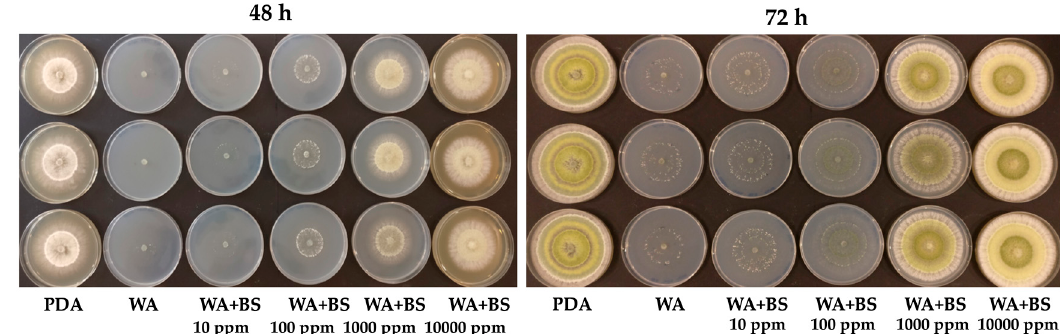
Figure 4. T. harzianum TH01 growing in starvation conditions in the presence or absence of BS2 ranging from 10 ppm to 10,000 ppm. On the left, the effects of BS2 at 48 h, on the right the effects at 72 h. The bio-assay was performed in triplicate. PDA = Potato Dextrose Agar; WA = water agar; BS =